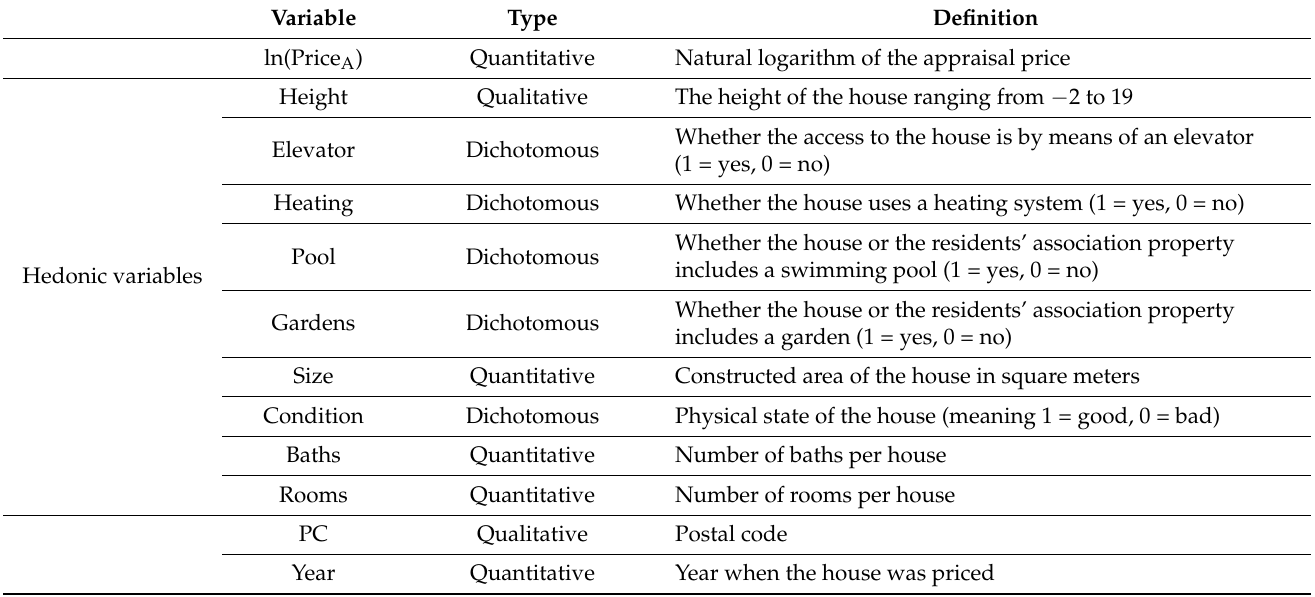
Table 1. Definitions of the explanatory variables.